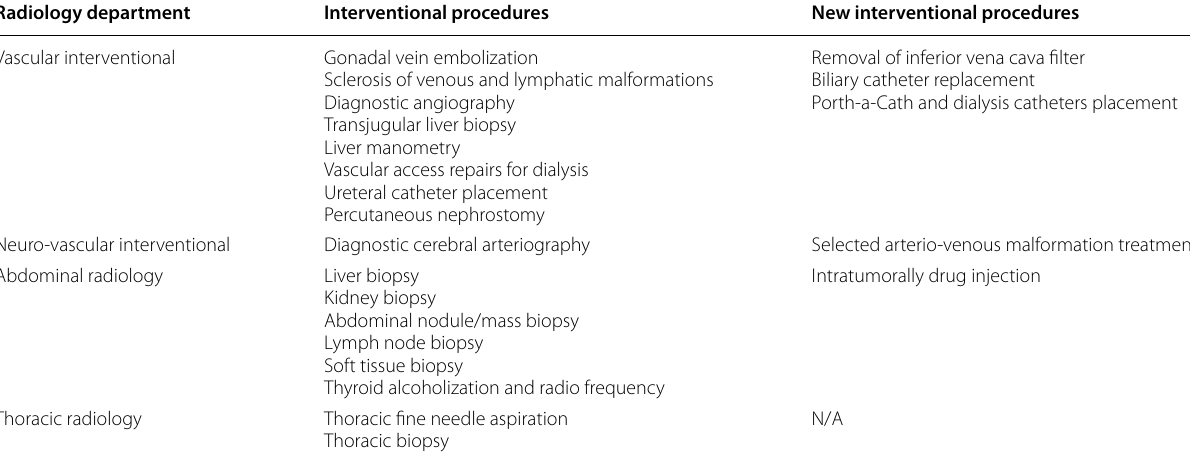
Table 2 List of techniques suitable for post‑procedure caring in the Radiology Day Unit Radiology